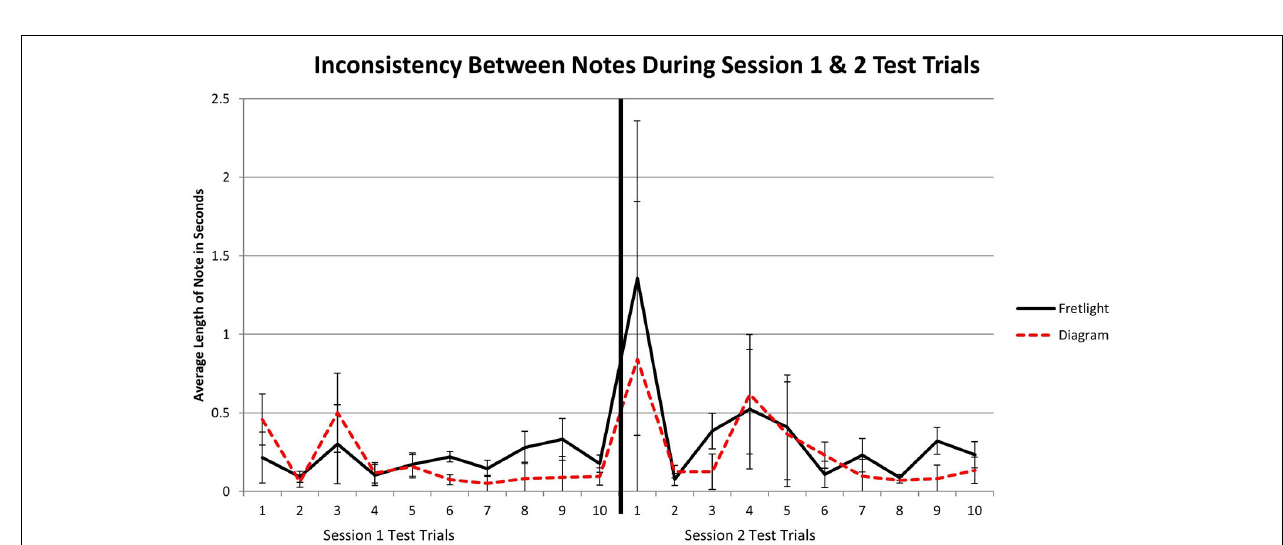
FIGURE 10 | Inconsistency between notes during test trials for Experiment 2 across session 1 and 2.